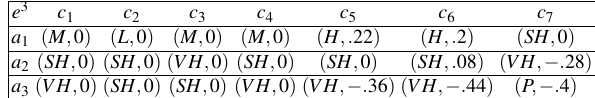
Table 7. Unified information provided by e 3 .